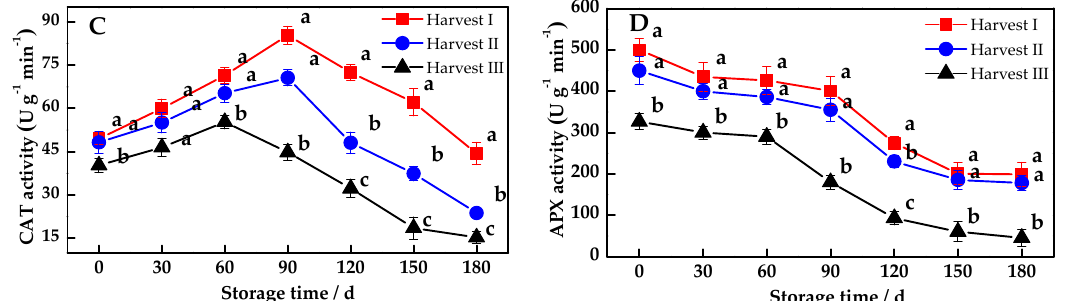
Figure 2. Dynamic changes for the antioxidant enzymes activities of Majiayou pomelo (MP) during storage at ambient temperature. ( A ) Changes for the superoxide dismutase (SOD) activity; ( B ) Changes for the peroxidase (POD) activity; ( C ) Changes for the catalase (CAT) activity; ( D ) Changes for the ascorbate peroxidase (APX) activity. The different letters for the same storage time indicates a significant difference ( p < 0.05).